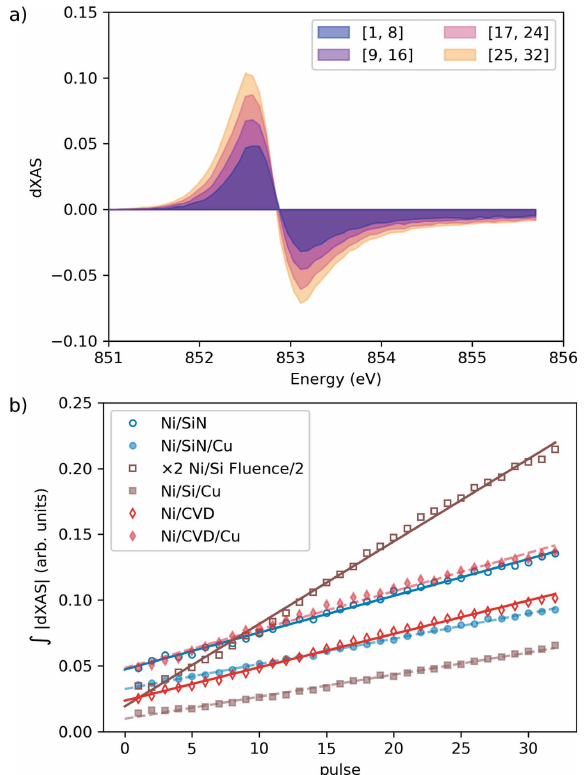
Figure 11 ( a ) Transient change in XAS in the Ni/Si 3 N 4 sample as a function of photon energy for selected pulses in the train as given by the pulse range in the corresponding legend. The time delay was 0.5 ps, the laser fluence was 7 mJ cm (cid:2) 2 , and the pump wavelength was 800 nm. The repetition rate of the 32 pulses during the FEL train was 280 kHz. ( b ) Integral of the absolute change in XAS as a function of the pulse number in the train, ranging from 1 to 32. The points are the measured data, while the lines are linear fits.